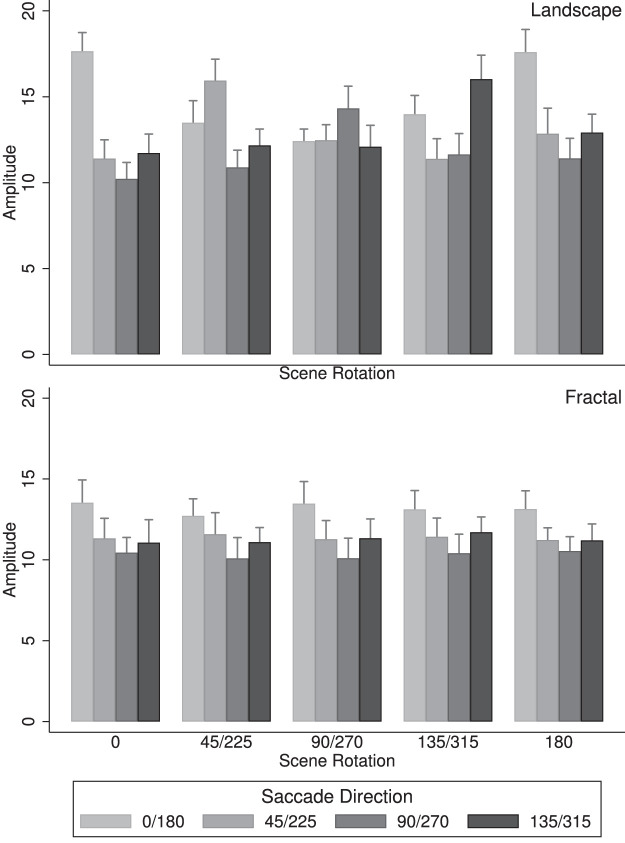
Saccade amplitudes along four axes in world coordinates, for landscape scenes (top) and fractal scenes (bottom). Data show the mean amplitudes of saccades (in degrees) and standard error bars along each axis and for the five scene rotation groups across participants.